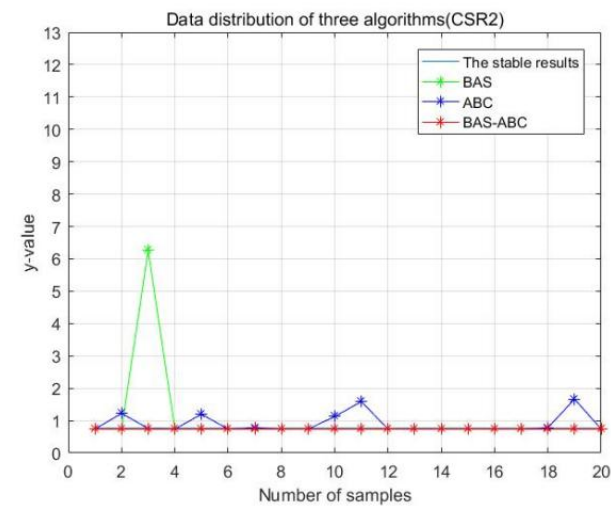
Figure 16. Data distribution-20 of three algorithms (CSR2).